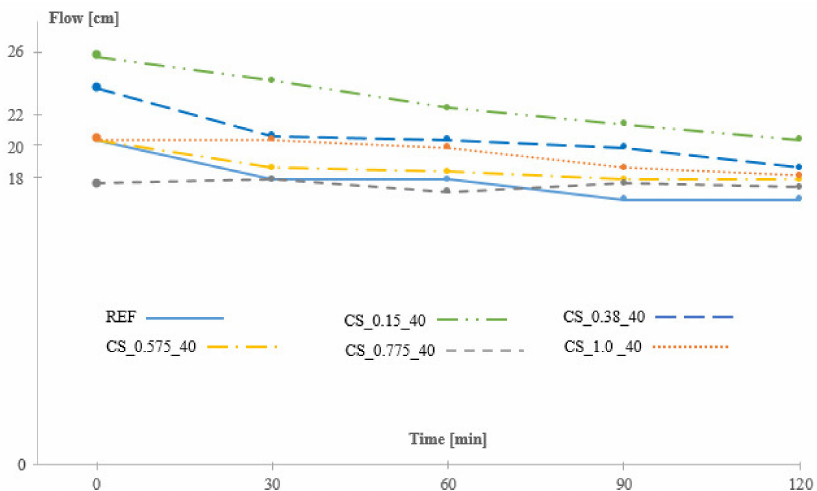
Figure 2. Initial flow and flow over time of the reference mixture and the mixtures containing SAPs with di ff erent amounts of cross-linker, Series